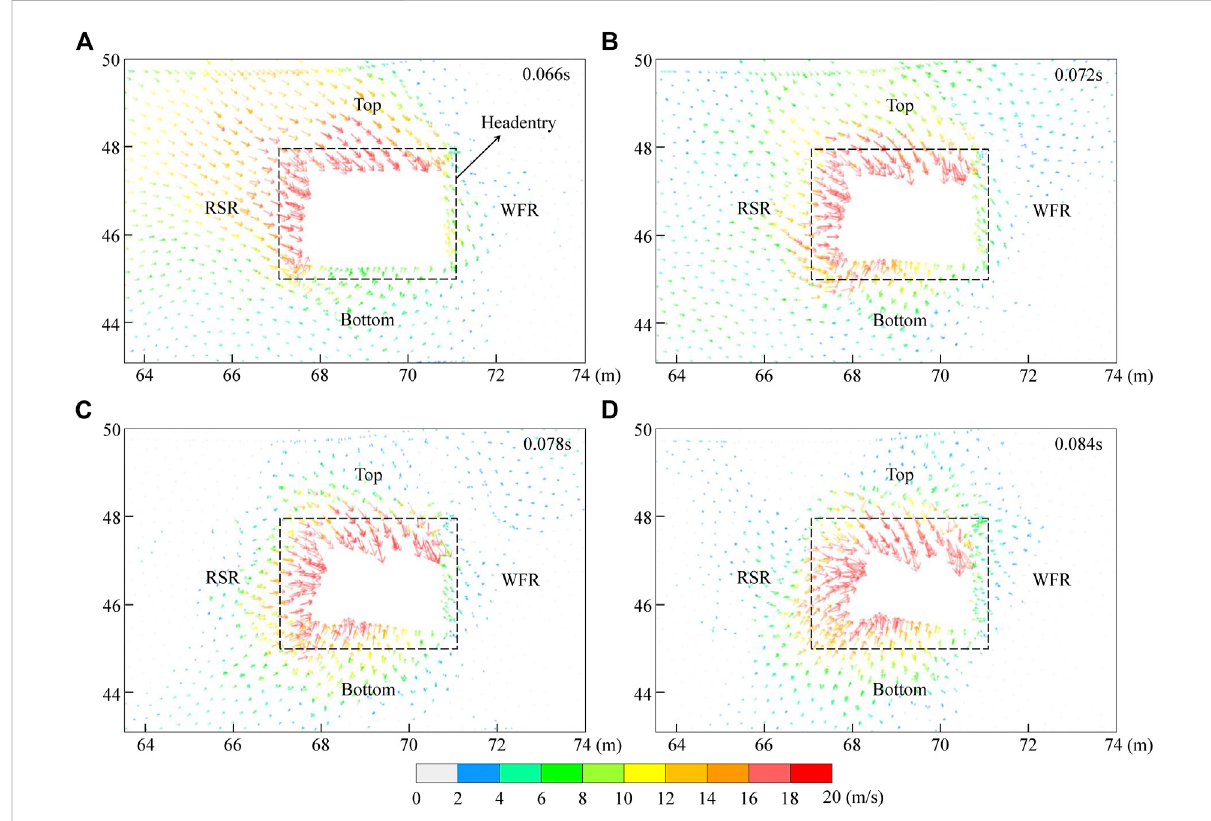
FIGURE 10 Velocity vectors around the headentry at different dynamic times: (A) dynamic time is 0.066s in the MSTCB, (B) dynamic time is 0.072s in the MSTCB, (C) dynamic time is 0.078s in the MSTCB, and (D) dynamic time is 0.084s in the MSTCB.